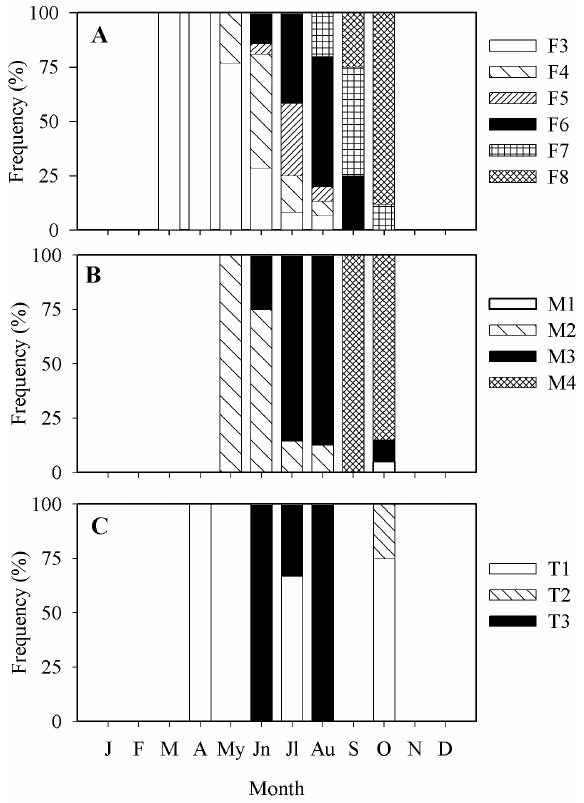
Fig . 3. – Monthly evolution of percentage of mature gonad stages for females (A), males (B) and transitionals (C) of Epinephelus marginatus . Female gonad stages are: F3: developing, F4: maturing, F5: ripe, F6: spawning, F7: spent, F8: resting; male stages are: